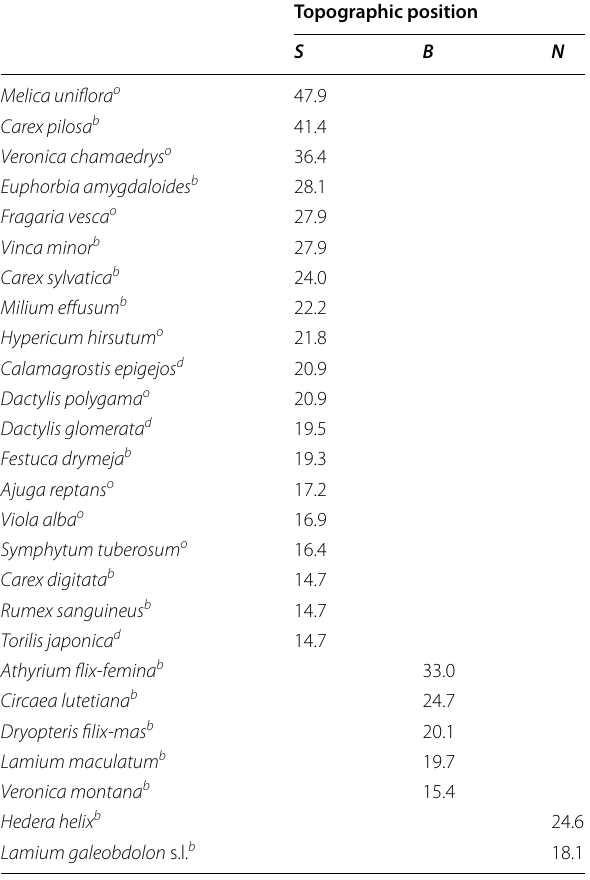
Table 2 List of diagnostic species for topographic positions (S: south-facing slope, B: bottom, and N: N-facing slope) in dolines. Within blocks, species are listed by decreasing values of the phi (Φ) coefficient. Fidelity values (Φ 100) of beech forest species, × oak forest species, and species of disturbed forests are indicated with superscripts b, o, and d, respectively. Non-diagnostic species were excluded with Fisher’s exact test ( p <